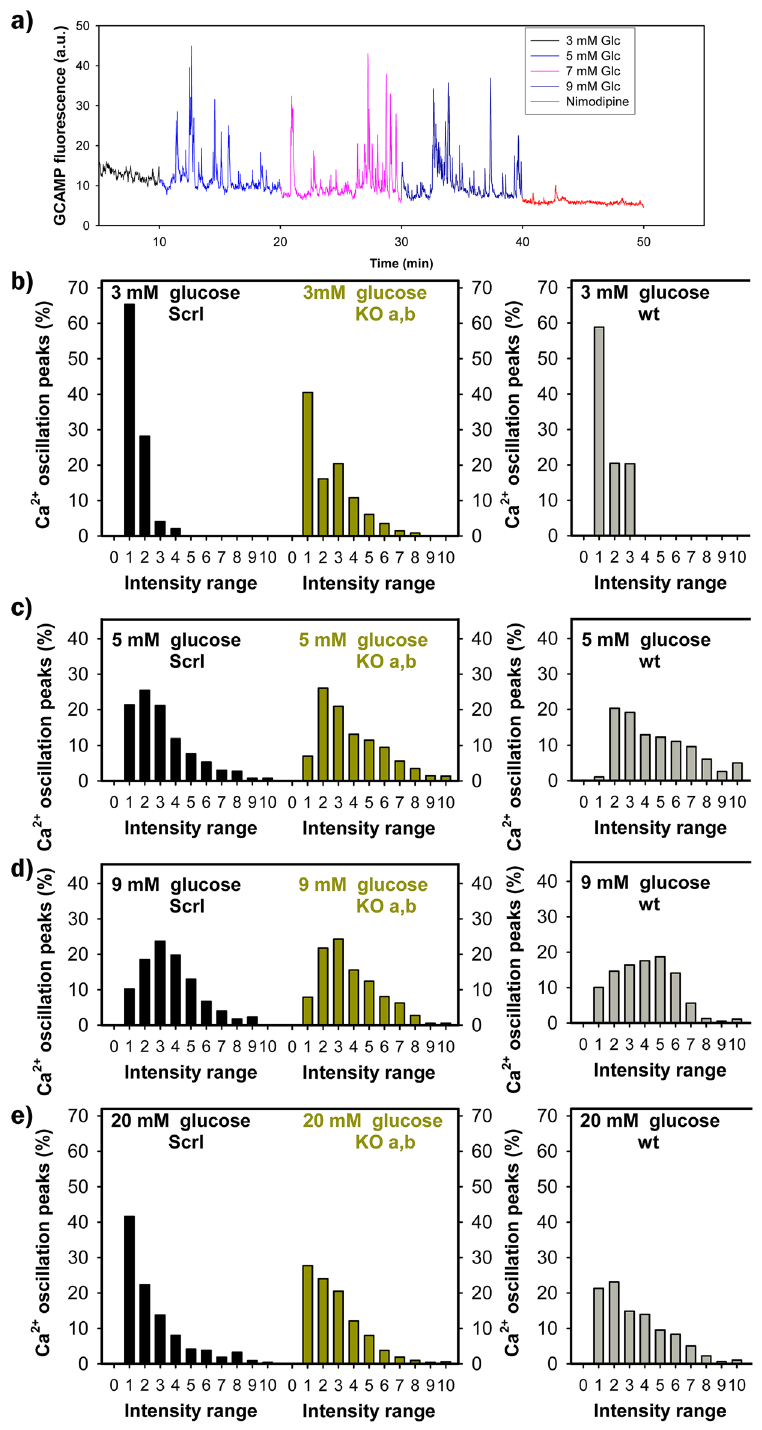
Figure 5. Ca 2+ oscillations are slightly improved at 3 and 20 mM glucose in Nkx6.1-ablated INS-1E cells as surveyed by GCaMP6 fluorescence probe—( a ) shows typical oscillations in cytosolic Ca 2+ , monitored by confocal microscopy of GCaMP6 fluorescence probe in each single cell: color-coding indicates Ca 2+ -oscillations after glucose adjustment to distinct concentrations as indicated. In the end, 5 μM nimodipine was added. ( b – e ) Show the corresponding histograms of intensities of Ca 2+ -oscillations, binned in deciles for INS-1E scrl/scrl cells ( left, black ), grouped data of lines ( a ) and ( b ) of INS-1E Nkx6.1 – / – cells ( middle, green ) and wt cells ( right, gray ). Around 1000 Ca 2+ -oscillation peaks were taken into the statistics for each